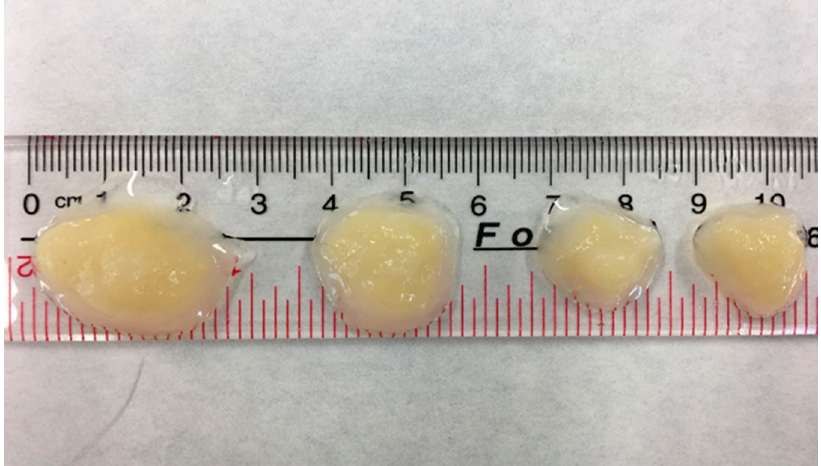
Figure 4. Mature granular biomass of Pseudomonas fluorescens 376 at operational day 150.